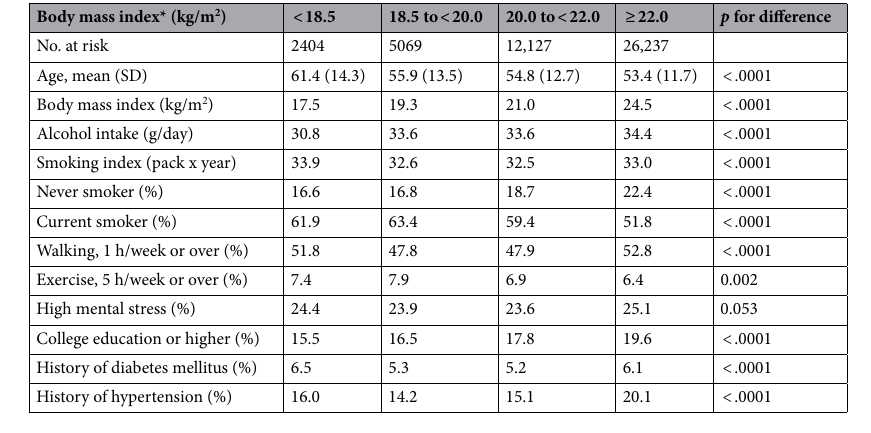
Table 1. Participants’ age-adjusted baseline demographics according to body mass index.